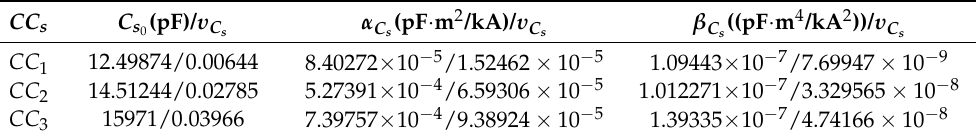
Figure 8a and are summarized in Table 2. (cid:2012) is the modulus of the magnetic field intensity gradient. Table 2. The values of (cid:1829) (cid:3046) Table 2. The values of C s ting of data from Figure 8a. of data from Figure 8a.